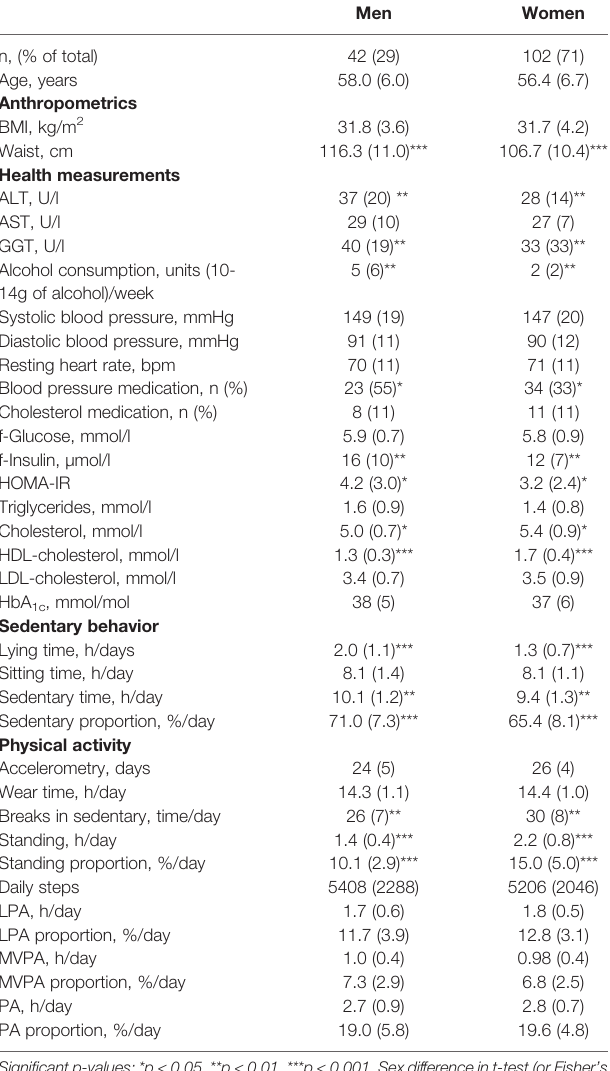
TABLE 1 | Characteristics of the study participants by sex. If not otherwise stated, the results are reported as mean (SD).